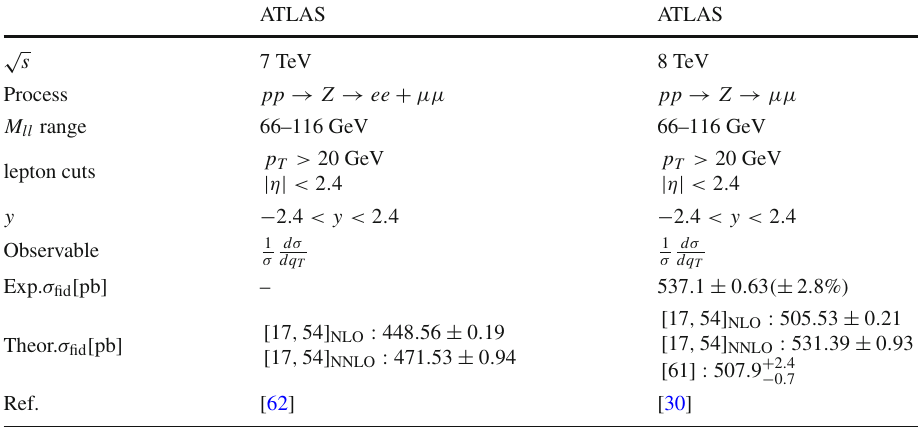
Table 5 The characteristics of the Z-boson production data measured by ATLAS collaborations